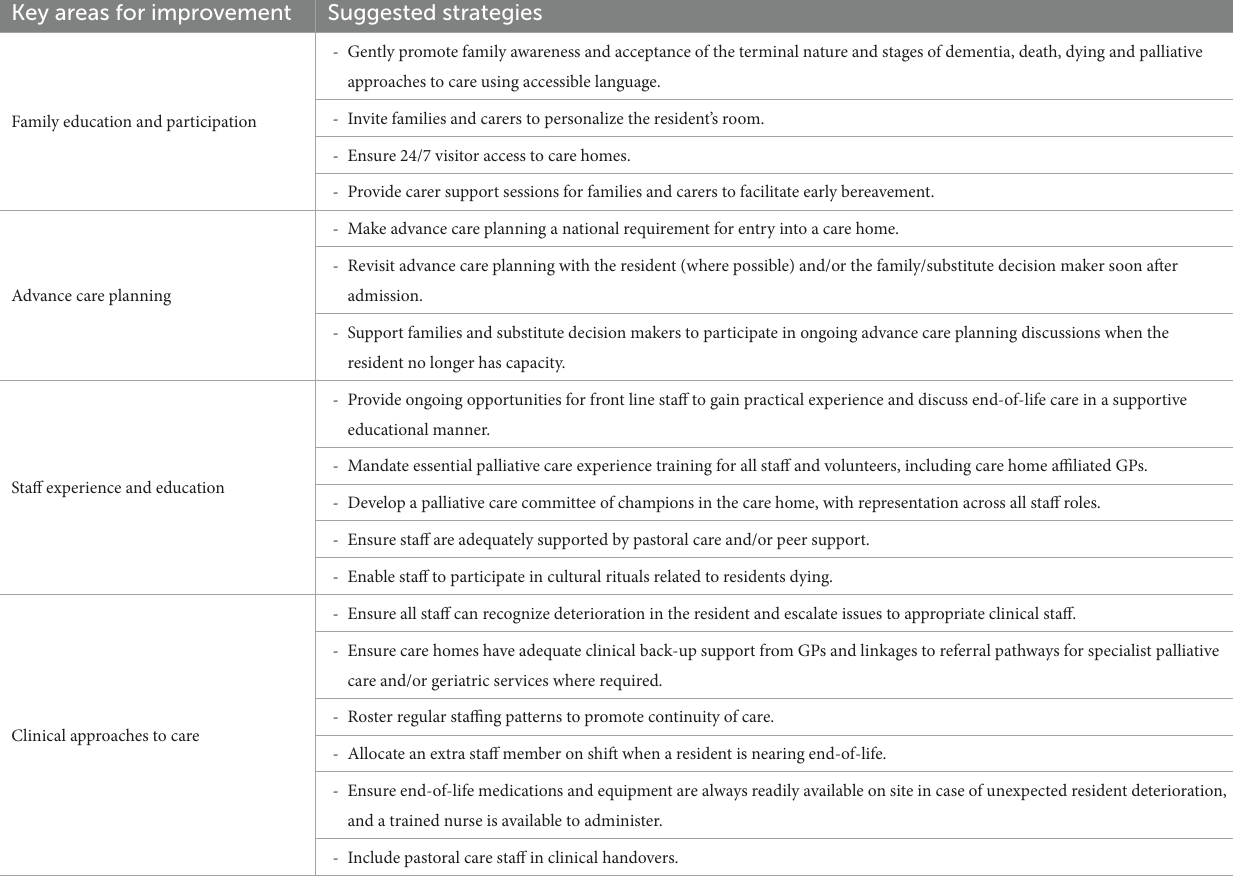
TABLE 2 Strategies suggested by participants for improving end-of-life care for residents living with dementia. Key areas for improvement Suggested